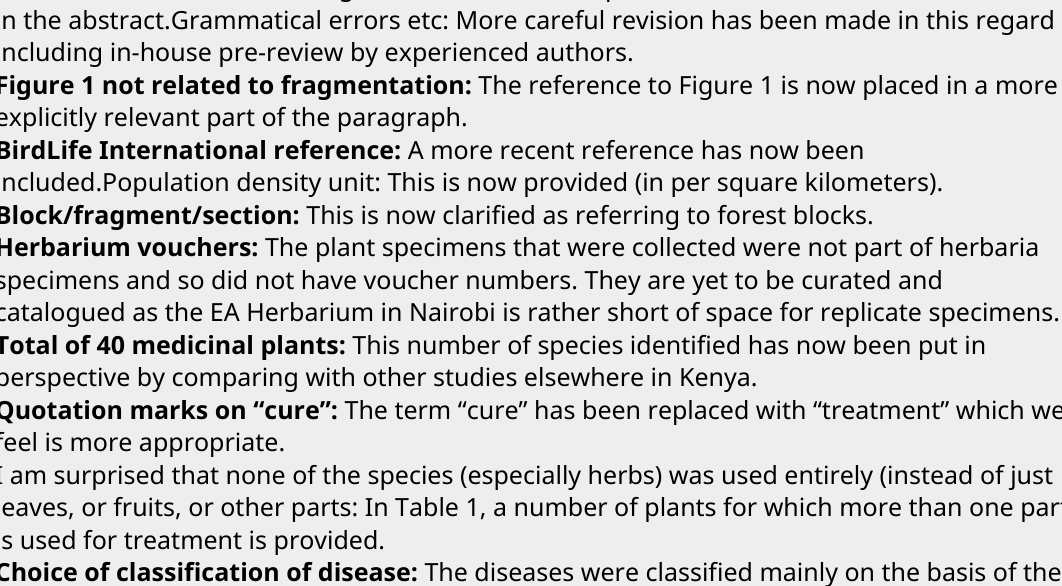
Figure 1 not related to fragmentation: The reference to Figure 1 is now placed in a more explicitly relevant part of the